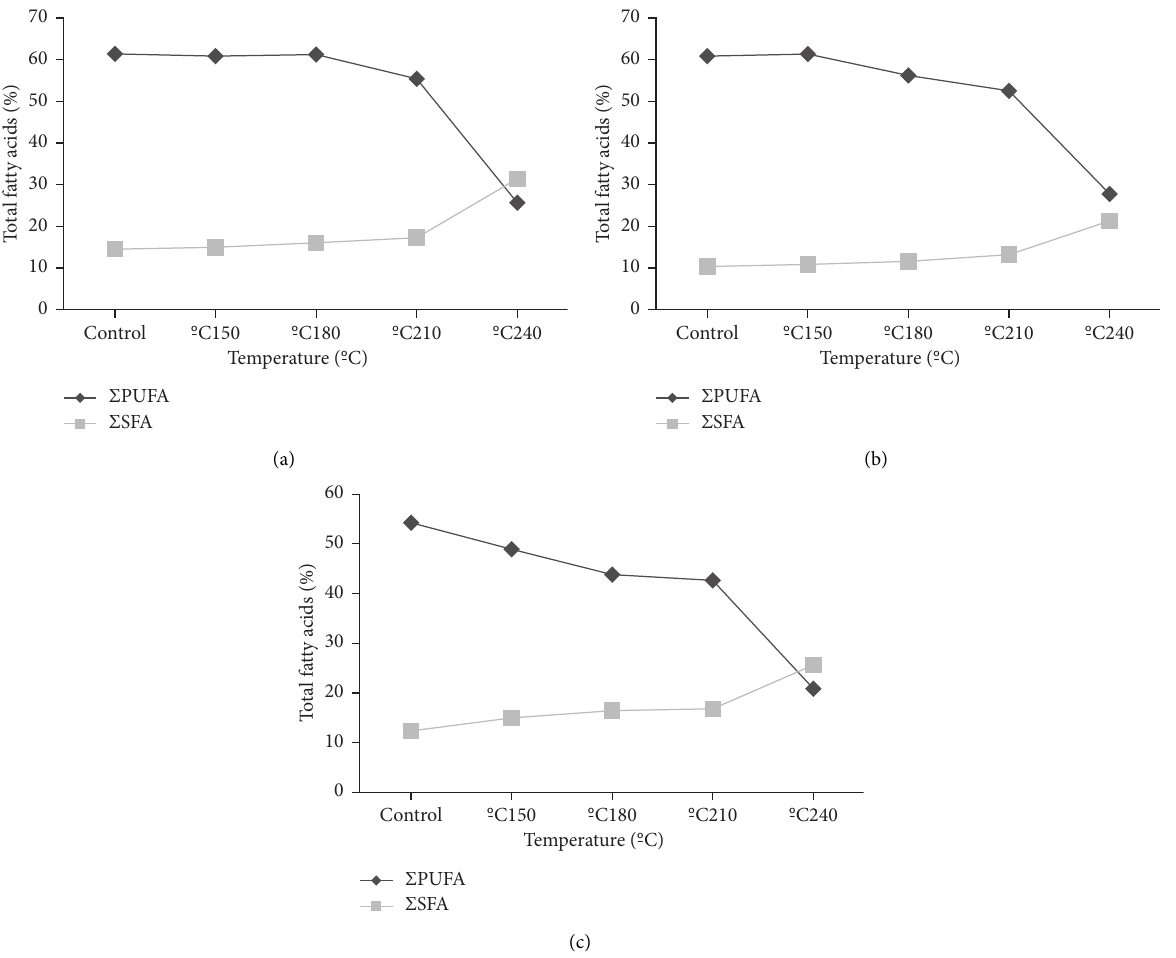
Figure 5: Change in the sum of polyunsaturated fatty acids ( Ʃ PUFAs) and saturated fatty acids ( Ʃ SFAs) during heating of soybean (a), sunflower (b), and corn oils (c) after 60 hours.